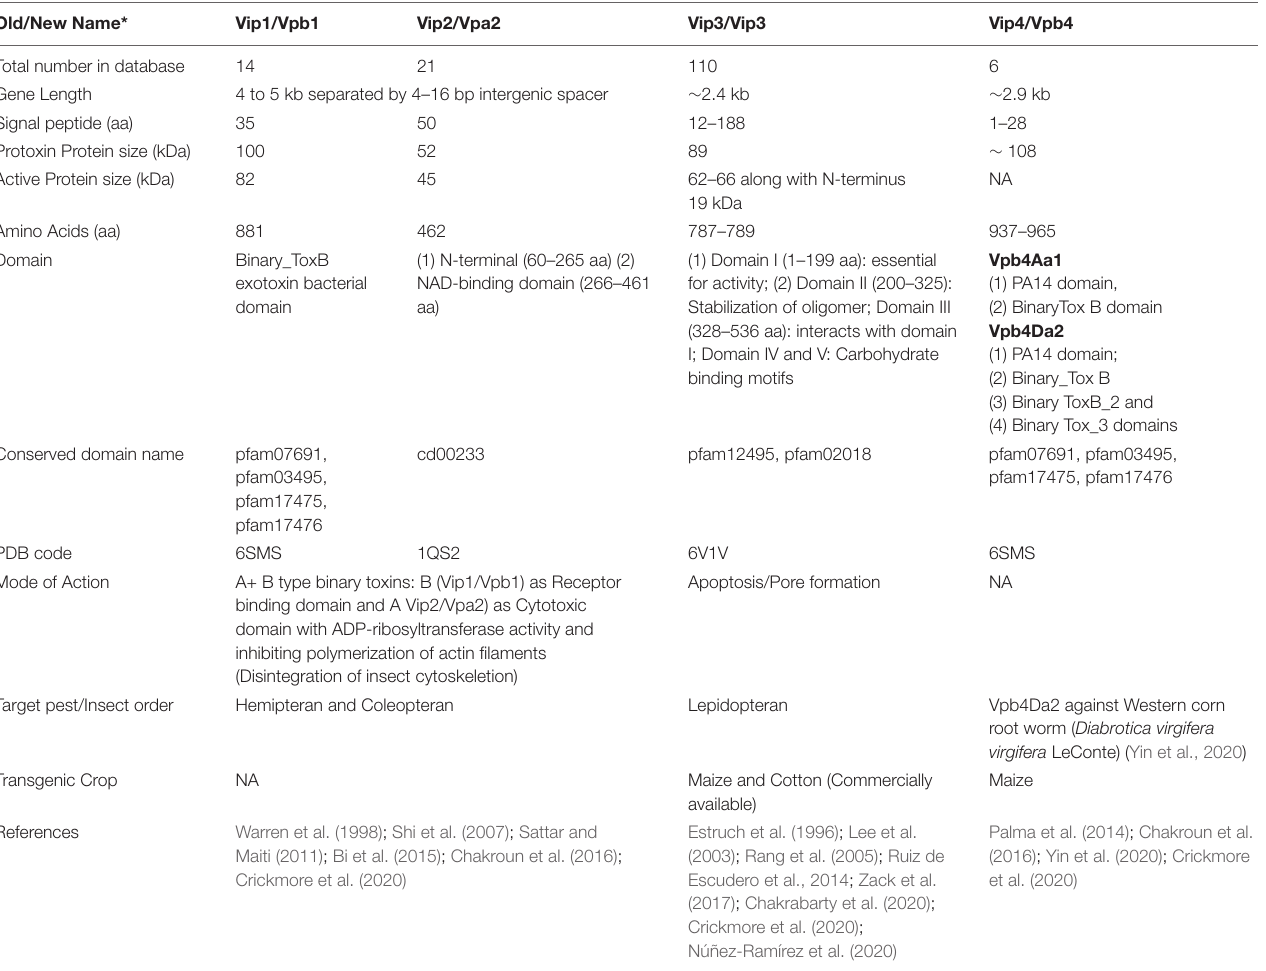
TABLE 1 | Characteristics of proteins belonging to VIP